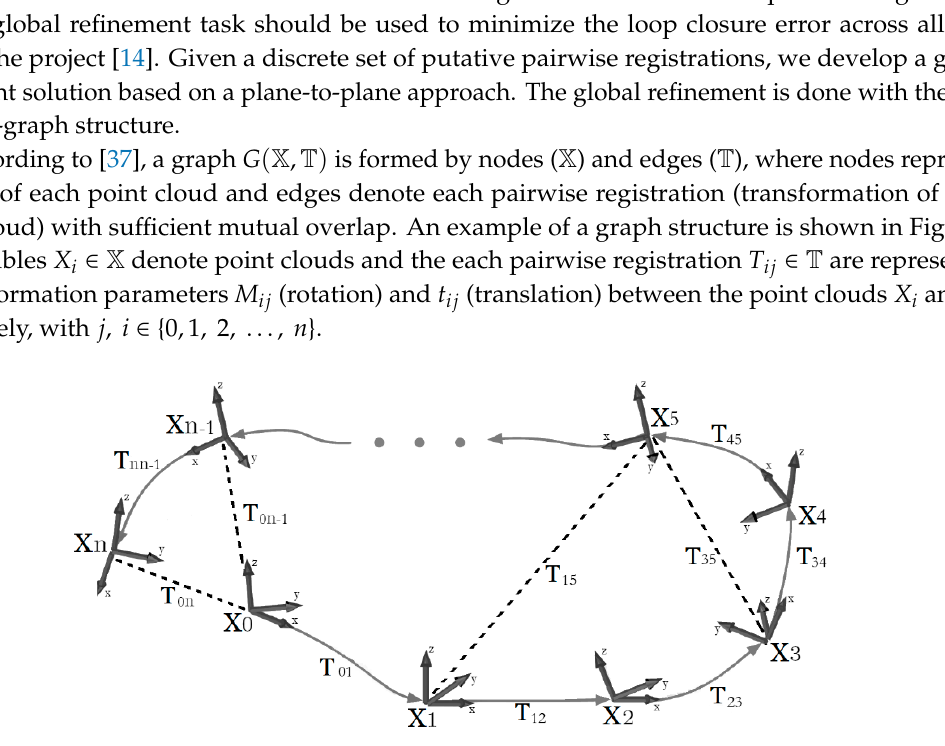
Figure 5. Illustration of pose-graph. Nodes represent the point clouds, and edges denote the pairwise registration.